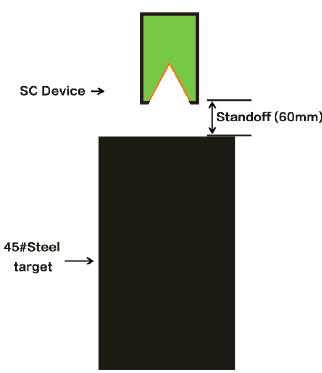
Figure 3. The schematic of the penetration experiments.